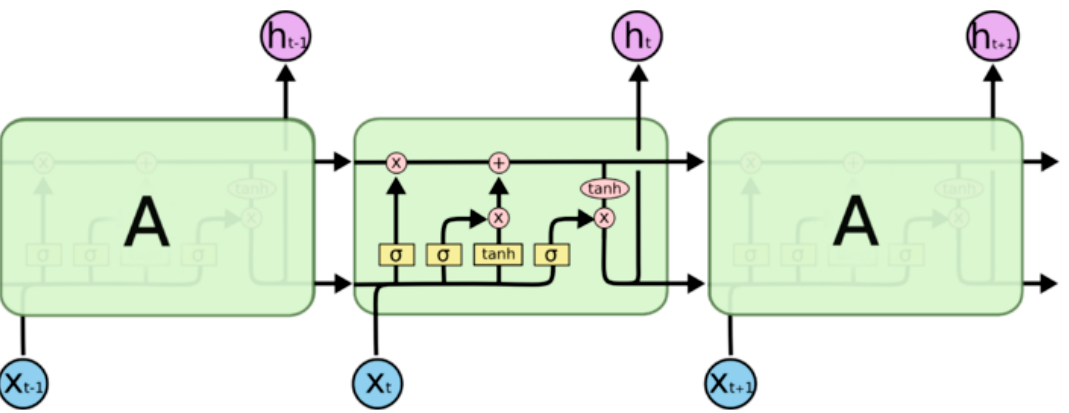
Figure 6. The structure of the long short-term memory (LSTM) network.